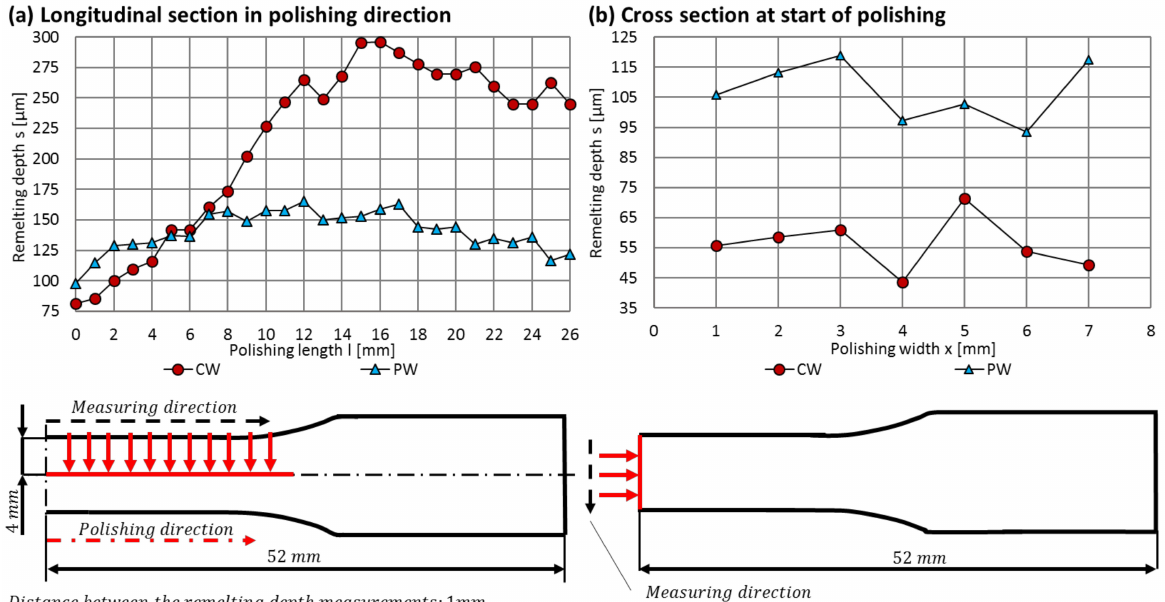
Figure 21. Resulting remelting depth s on the tensile specimens depending on the laser operation mode, ( a ) remelting depth in polishing direction, ( b ) remelting depth over polishing width at the starting position.